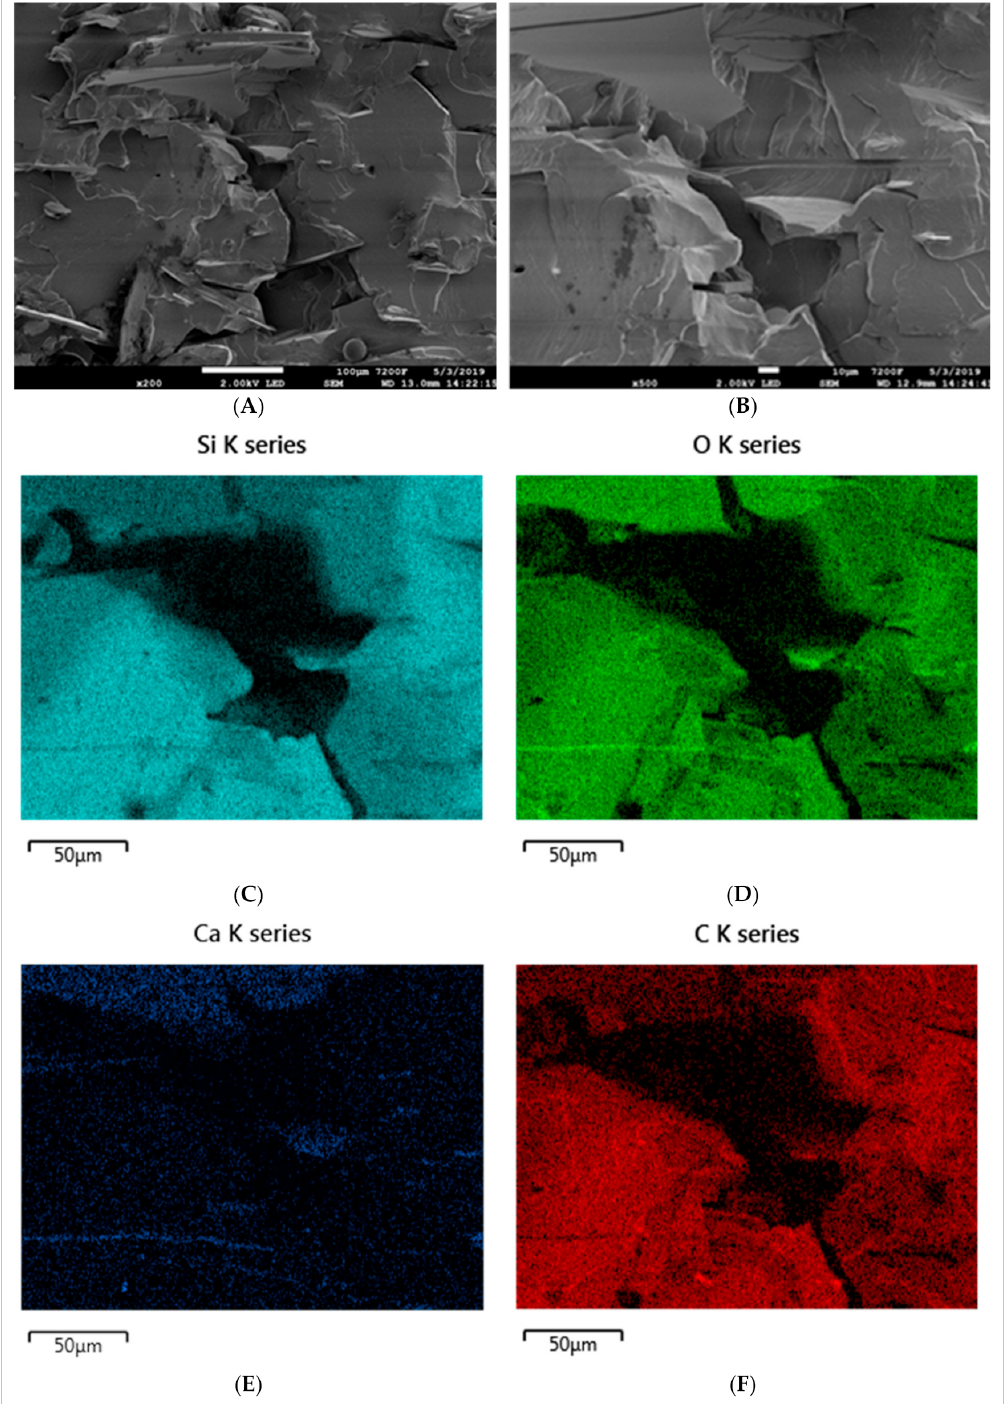
Figure 12. SEM images of the SR-3 composite at magnifications of ( A ) × 200 and ( B ) × 500. EDS mapping of SR-3 ( C ) silicon distribution, ( D ) oxygen distribution, ( E ) calcium distribution, and ( F ) carbon